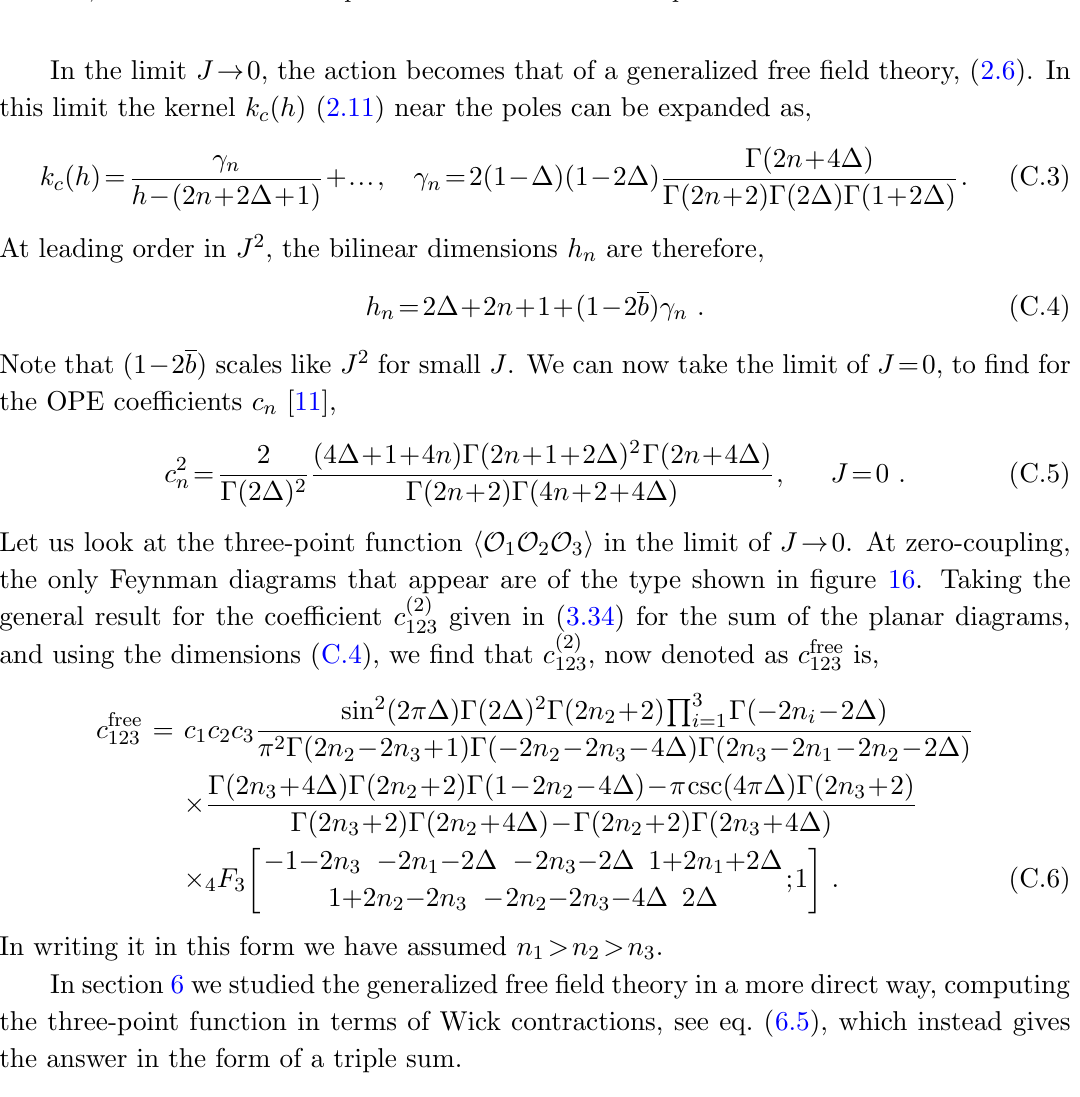
Figure 17. The fermion six point function. Using the split representation of the four-point function, we can obtain the six-point function from the three-point functions of the